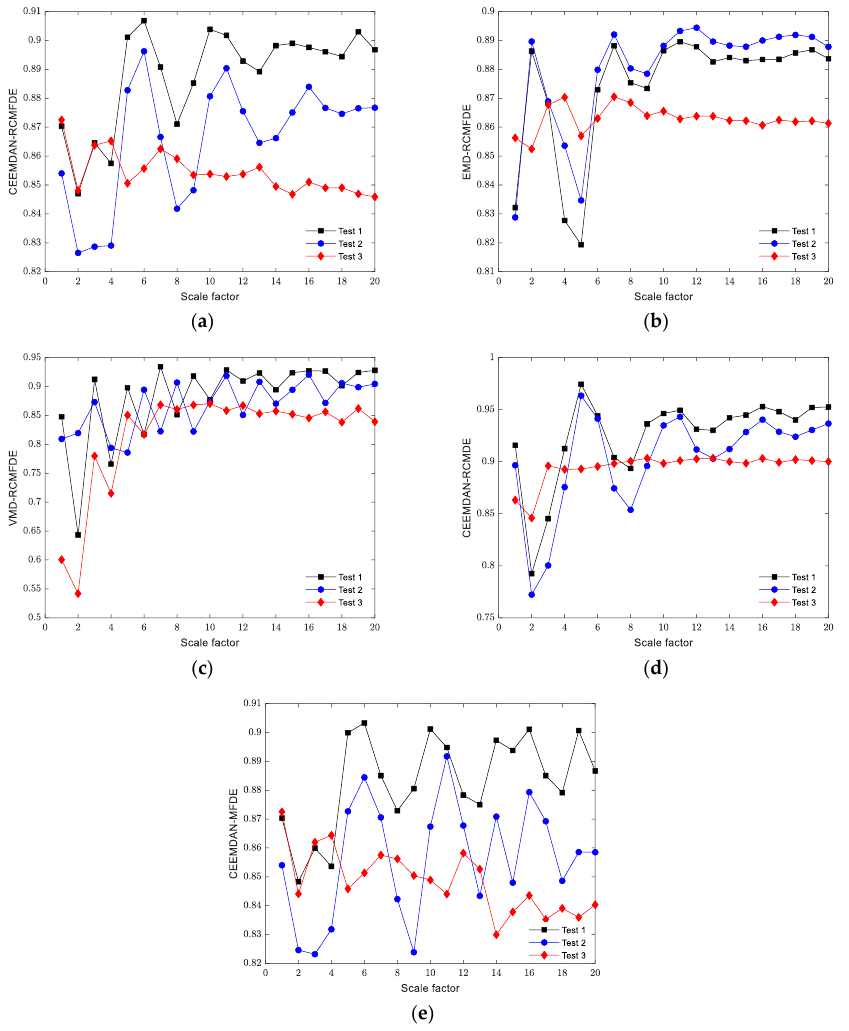
Figure 11. Relation between entropy and scale factor by different features under three test condi- tions: ( a ) CEEMDAN-RCMFDE; ( b ) EMD-RCMFDE; ( b ) VMD-RCMFDE ( d ) CEEMDAN-RCMDE; ( e ) CEEMDAN-MFDE.